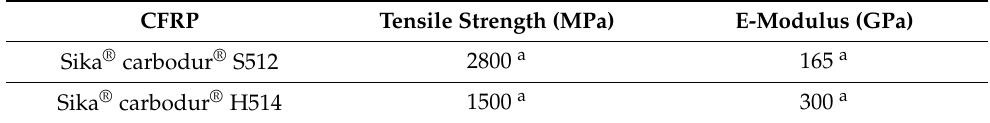
Table 3. The characteristics of CFRP.